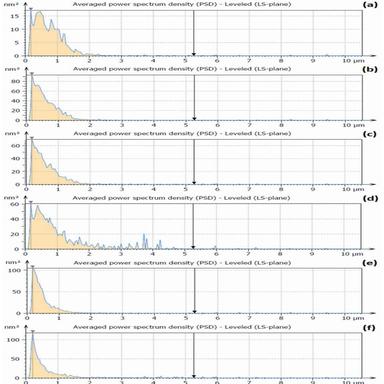
The most relevant diagram of PSD for the samples surface: a) BF1, b) BF2, c) BF3, d) B4, e) BF5 and, f) BF6.